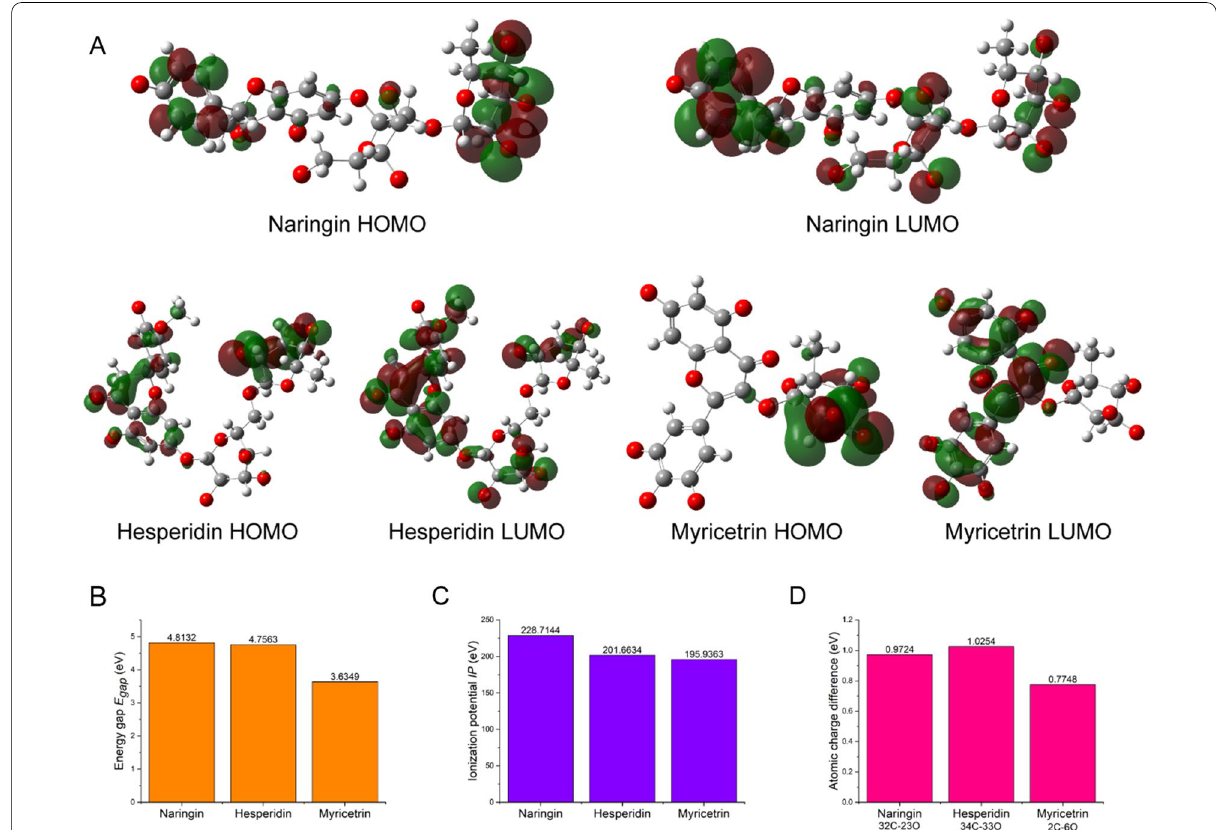
Fig. 4 A HOMO and LUMO distribution of protonated substrates. Red: positive, Green: negative. Energy gap B and ionization potential C of protonated substrates. D The C-O charge difference of the three substrate-specific glycosidic